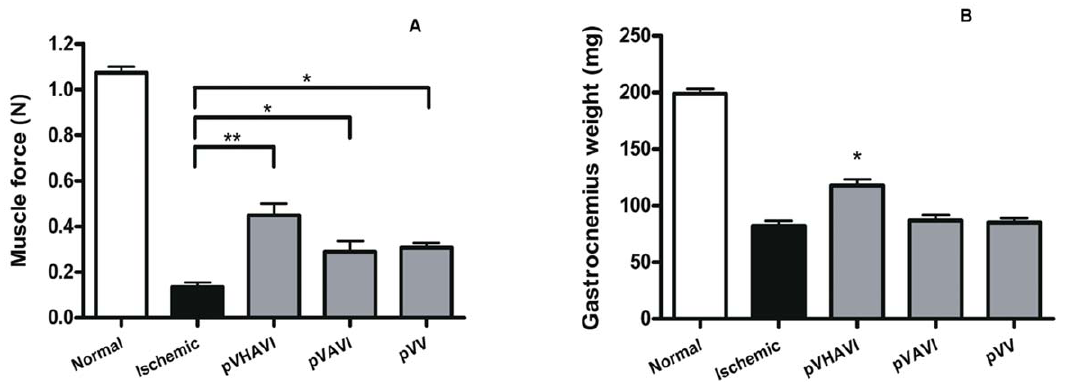
Figure 4. Determination of the mass and force of the gastrocnemius muscle. Muscle force (A) and mass (B) were measured 4 weeks after gene therapy. For each group, seven mice were used. The sham-operated and non-ischemic groups showed no difference in their results and are denoted here as normal. (A) * P , 0.05; ** P , 0.005. (B) * P , 0.05, pVHAVI in comparison to each group.